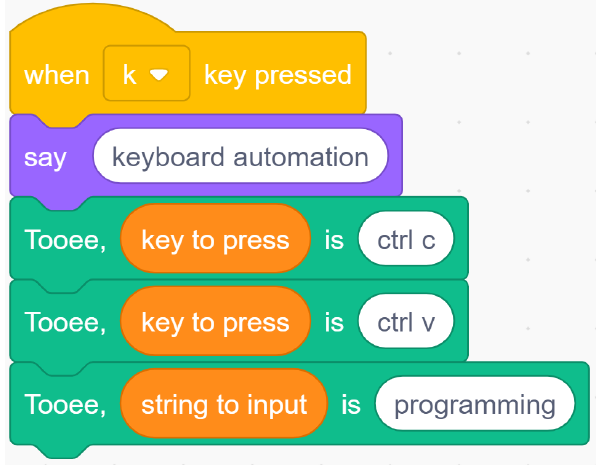
Figure 7. Example Scratch code to press the hot keys CTRL + C and CTRL + V and enter the character string programming .